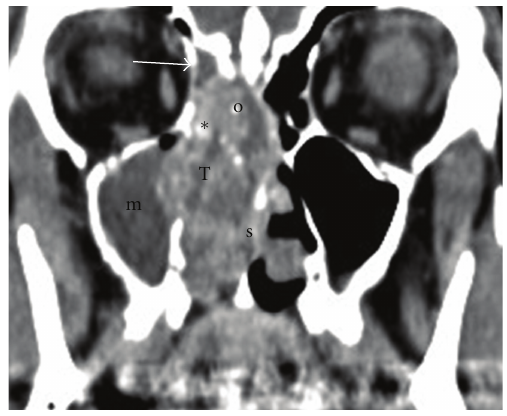
Figure 1: Initial lesion, CT scan: the tumor (T) is centered on the olfactory cleft (o), pushing the septum (s). The invasion of the middle turbinate and the presence of intratumoral calcifications ( ∗ ) could indicate the presence of chordoma. Ethmoidal attic ( −→ ) and maxillary sinus (m) are retentional.